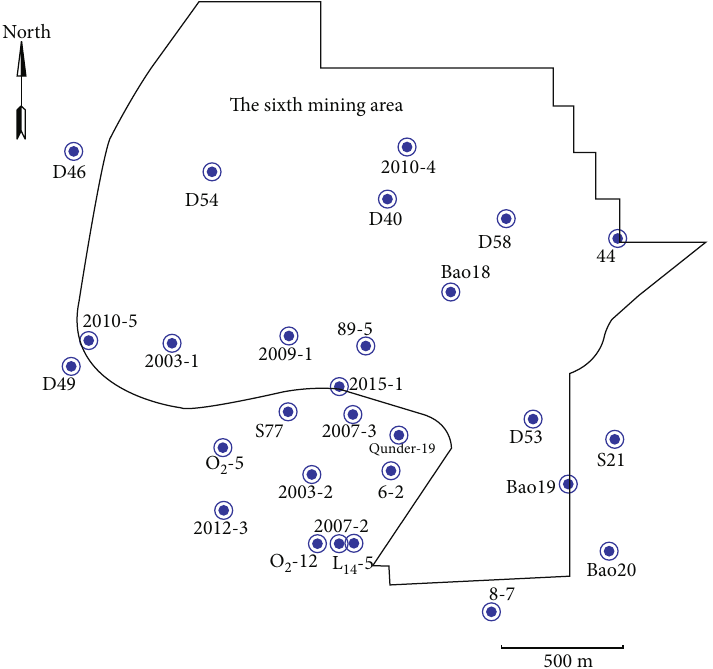
Figure 2: The scope and borehole location of the sixth mining area of Baodian Coal